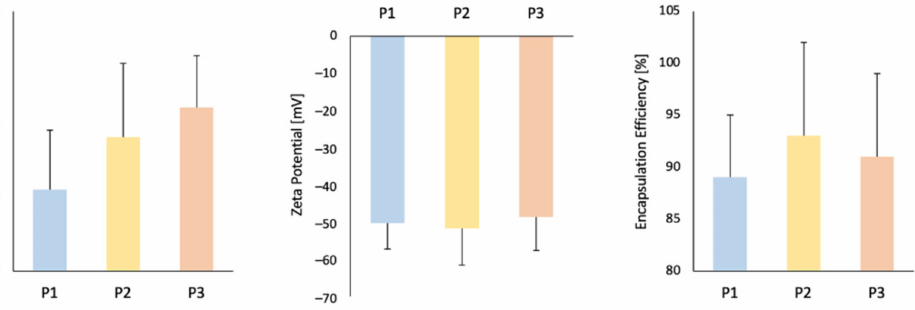
Figure 1. Average size ± SD, Zeta Potential ± SD and encapsulation efficiency ± SD (EE) for appropriate liposomal